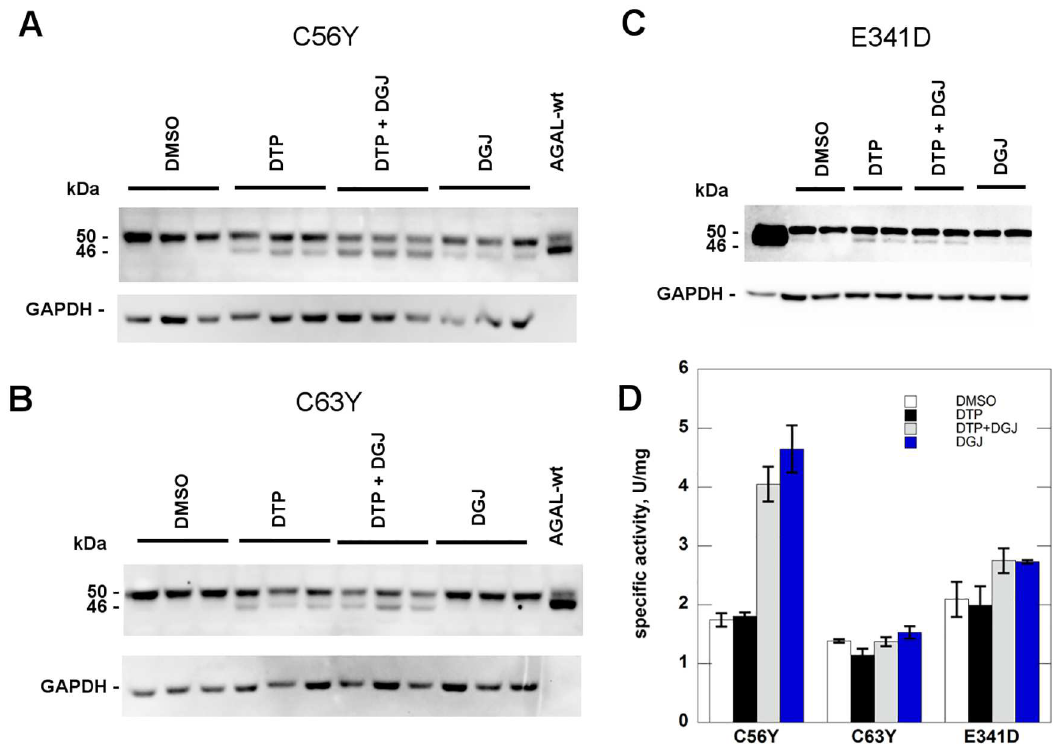
Fig 6. 2–6 dithiopurine promotes processing of some mutant human alpha-galactosidase. COS-7 cells were cultured in conventional medium and transfected with plasmid containingC56Y, C63Y and E341D mutants. Cells were treated with: DTP 6 mM, DGJ 1 microM, DGJ 1 microM plus DTP 6 mM. All the moleculeswere dissolved in DMSO and an appropriate control was realized. After 48 h incubation, the cells were scraped and lysed then water-soluble extracts were analysedby western blotting (A, B and C) and enzyme assay (D). Standard deviations are indicatedby bars.